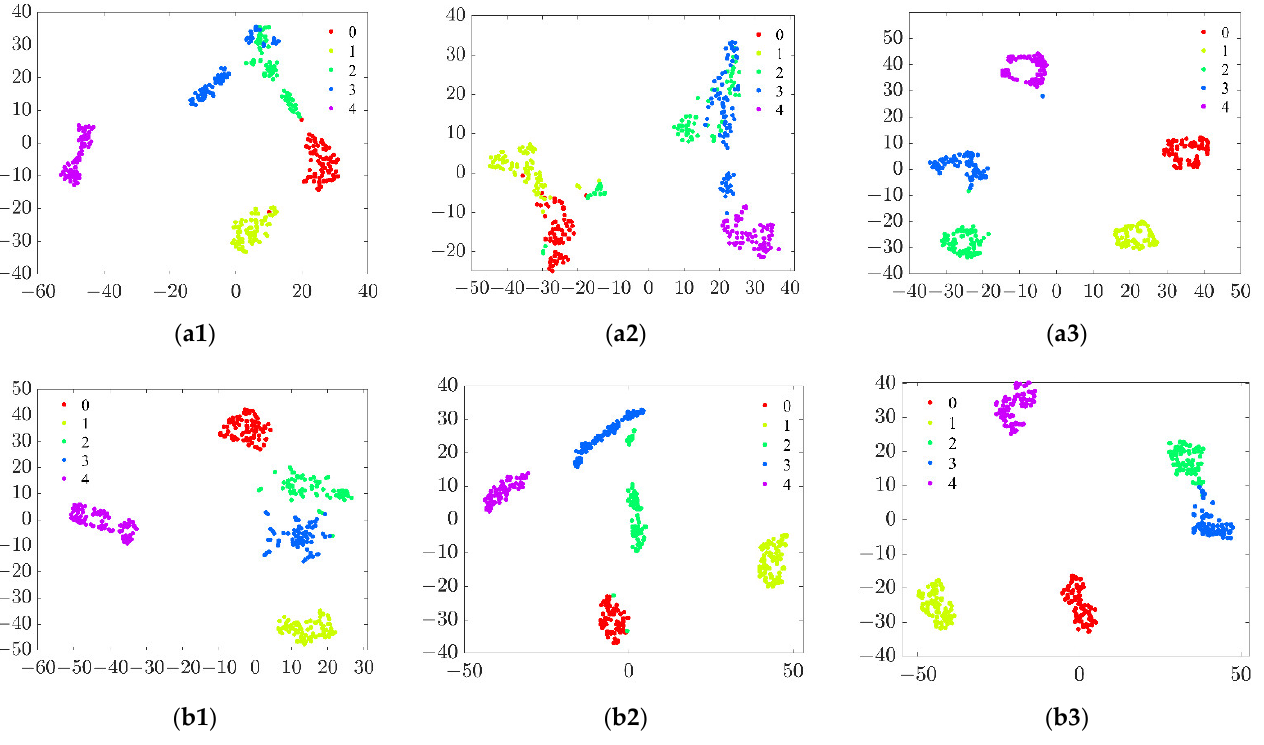
Figure 8. T-SNE visualization of features learned in the fully connected layer: ( a1 – a3 ) indicate the features of single-channel CNN from testing datasets A, B, and C; ( b1 – b3 ) indicate the features of CMA_MCFCNN from testing datasets A, B, and C.